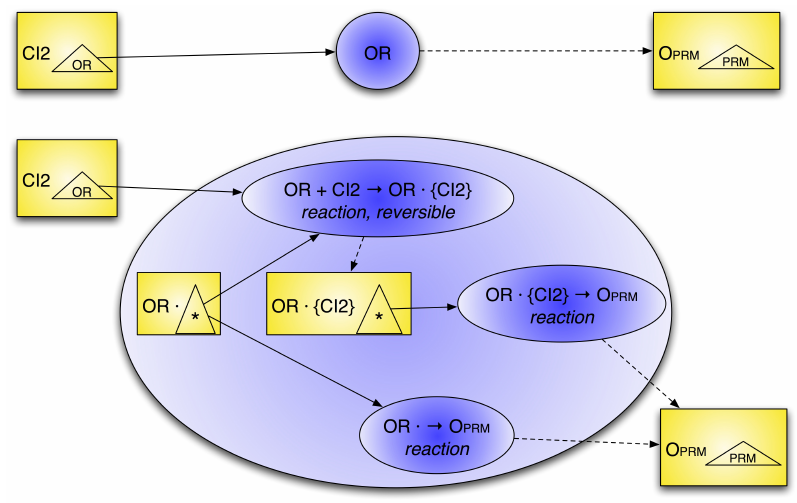
Figure 3: Use of a regulatory site as a shortcut for a set of chemical reactions. Top. The regulatory site OR (from Figure 2) is not a reaction. Bottom. The regulatory site demultiplication produces 2 new entities: OR · and OR · { CI 2 } , as it has only one regulator. By definition of the regula- tor and regulatory site, the OR · + CI 2 → OR · { CI 2 } reaction consumes the regulator CI 2 and the species OR · , creating the intermediate species OR · { CI 2 } . The regulator CI 2 binds to the biological site OR. If the stoichiometry is already present in the original ICR, it is added to the new ICR connecting CI 2 and the site of the OR · + CI 2 → OR · { CI 2 } reaction. The production reactions of the regulated species O PRM from OR · { CI 2 } or from OR · are automatically added, since the meaning of the regulatory site is that the production rate of the output species relies on the regulatory state of the